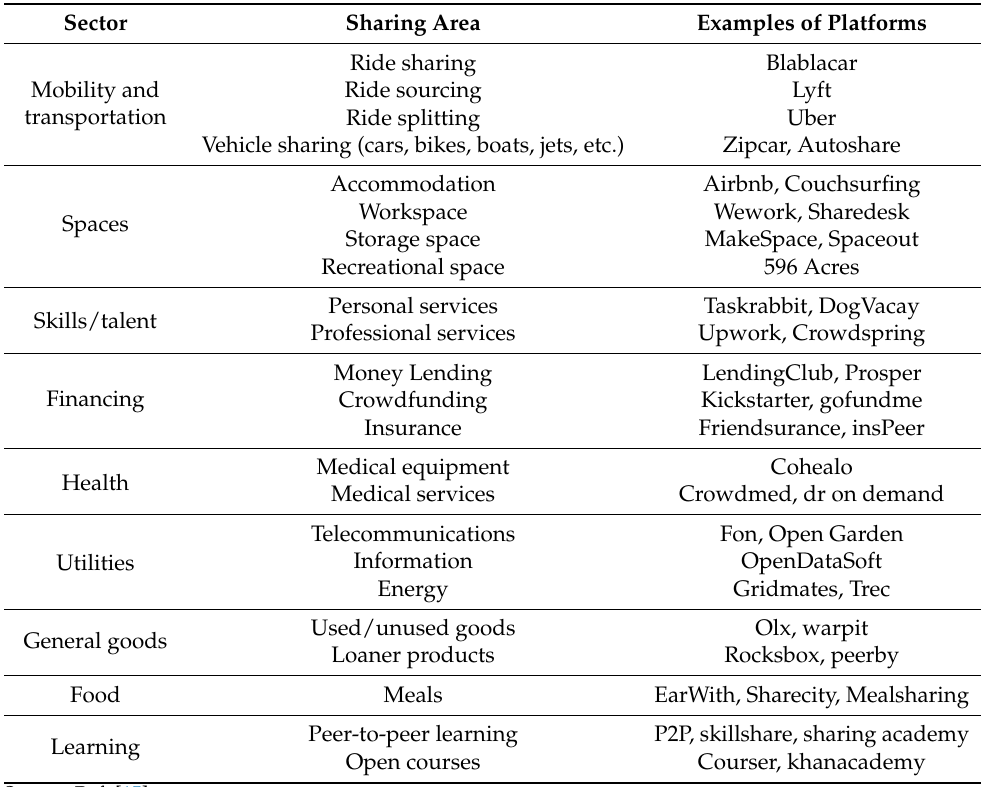
Table 1. Some of the key sectors of the sharing economy.